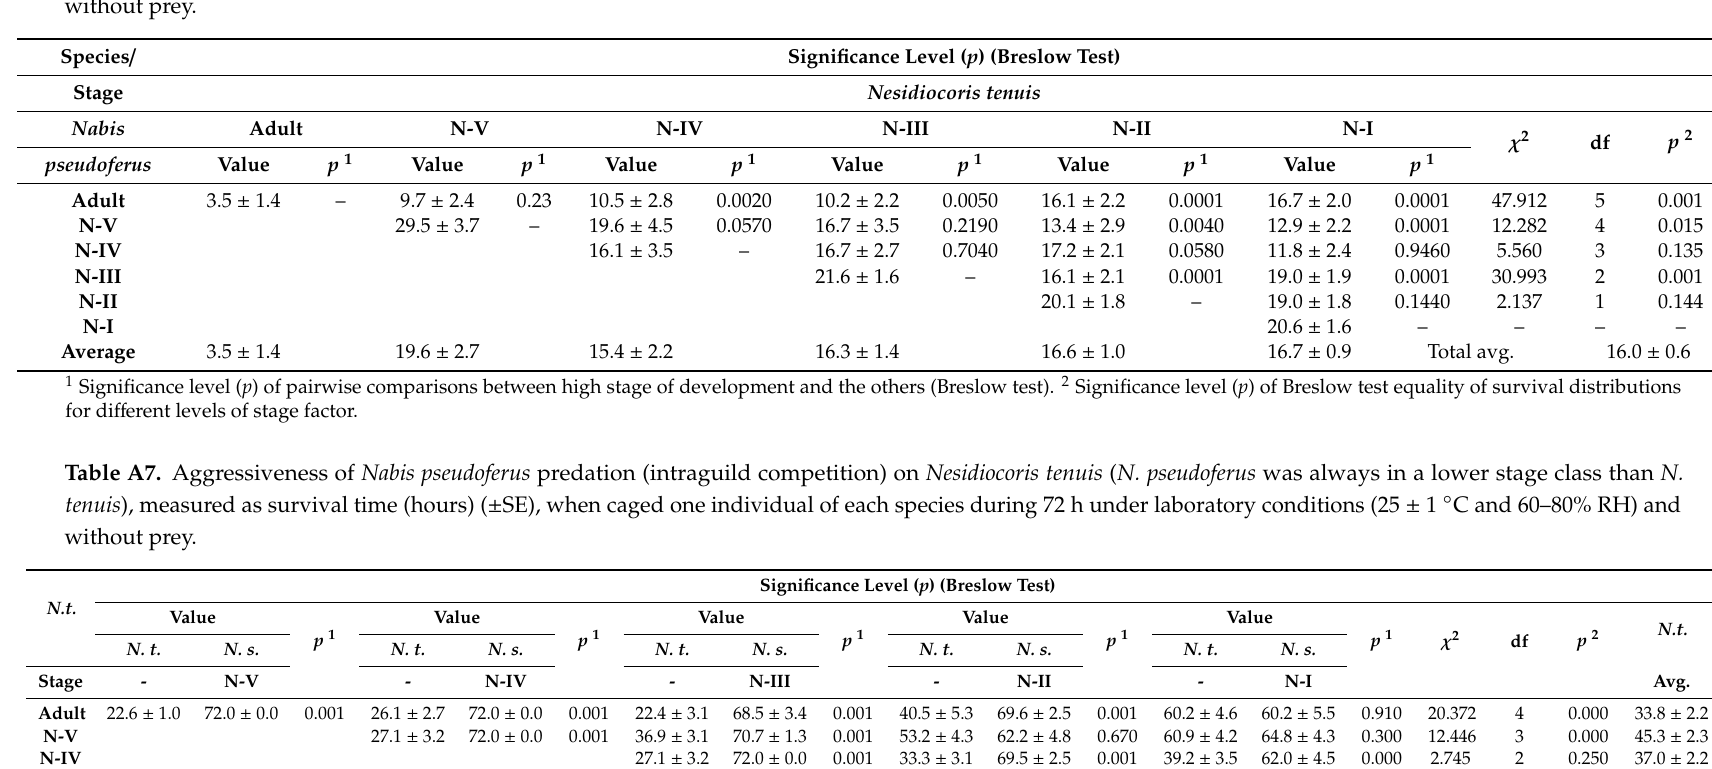
Table A6. Aggressiveness of Nabis pseudoferus predation (intraguild competition) on Nesidiocoris tenuis (both predatory species are in the same or lower stage class), measured as survival time (hours) ( ± SE), when caged one individual of each species during 72 h under laboratory conditions (25 ± 1 ◦ C and 60–80% RH) and without prey.